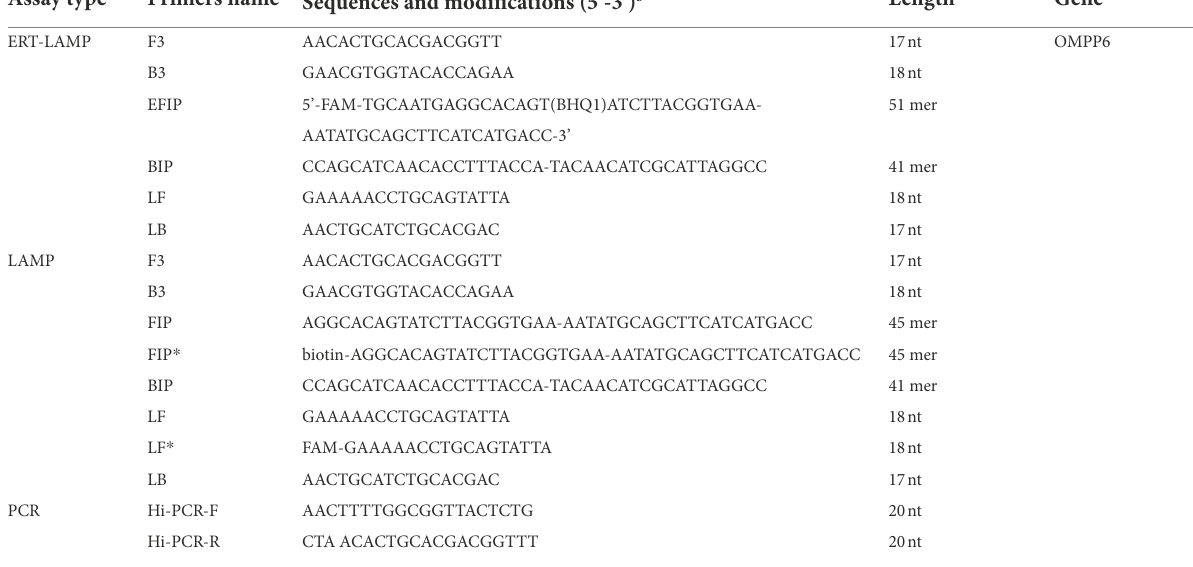
TABLE 1 Primers used in this study. Assay